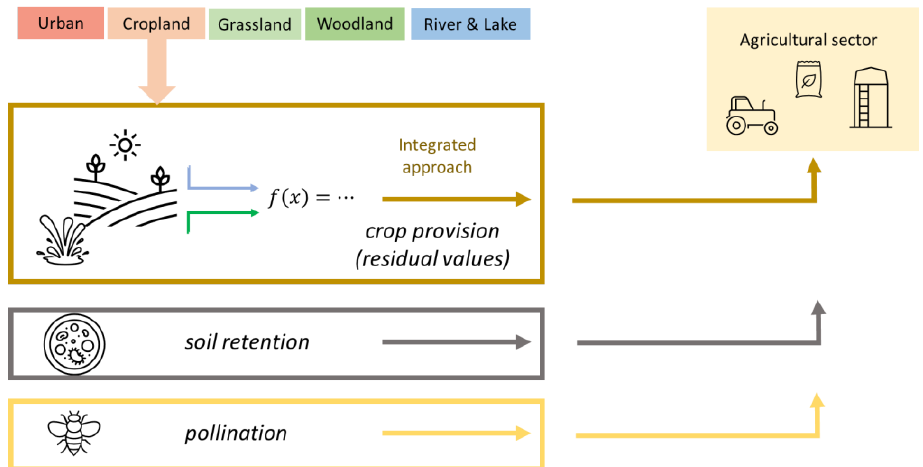
Figure 5. Crop provision assessment based on a mixed comprehensive approach and ecosystem service modelling.